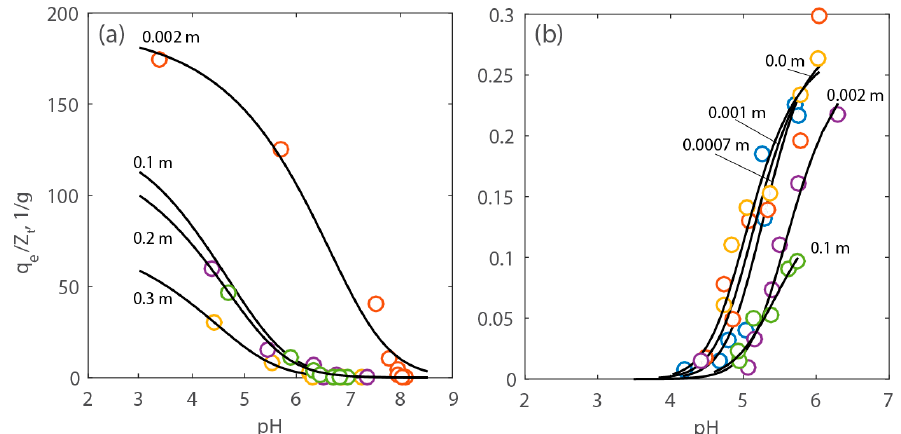
Figure 8. Experimental and modeling results expressed as normalized adsorption capacity ( q e / Z t ) of Ca 2+ vs. pH at various electrolyte concentration. Adsorption capacity of ( a ) protons and ( b ) calcium onto PAA-MNPs’ surface.